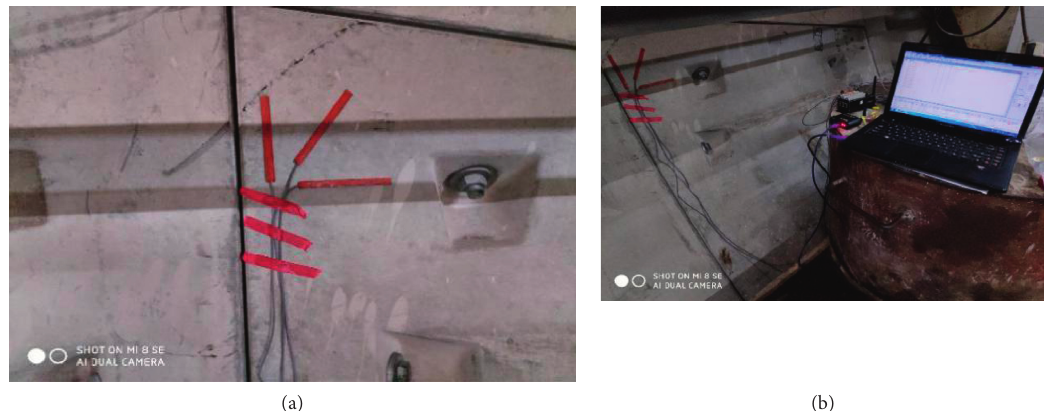
Figure 18: Site monitoring chart. (a) Layout of strain gauges. (b) Data acquisition of static monitor.